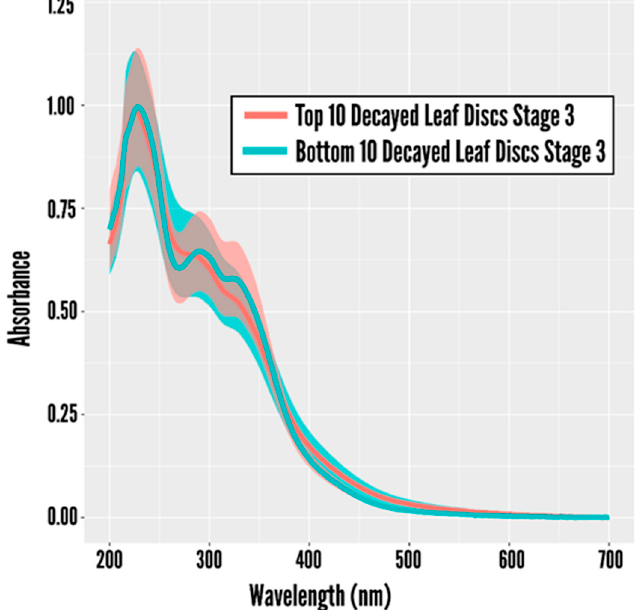
Figure 7. UV spectroscopy of NaOH extracts for the 10 leaf discs with the highest and lowest first principal component values (e.g., the most and least decayed).